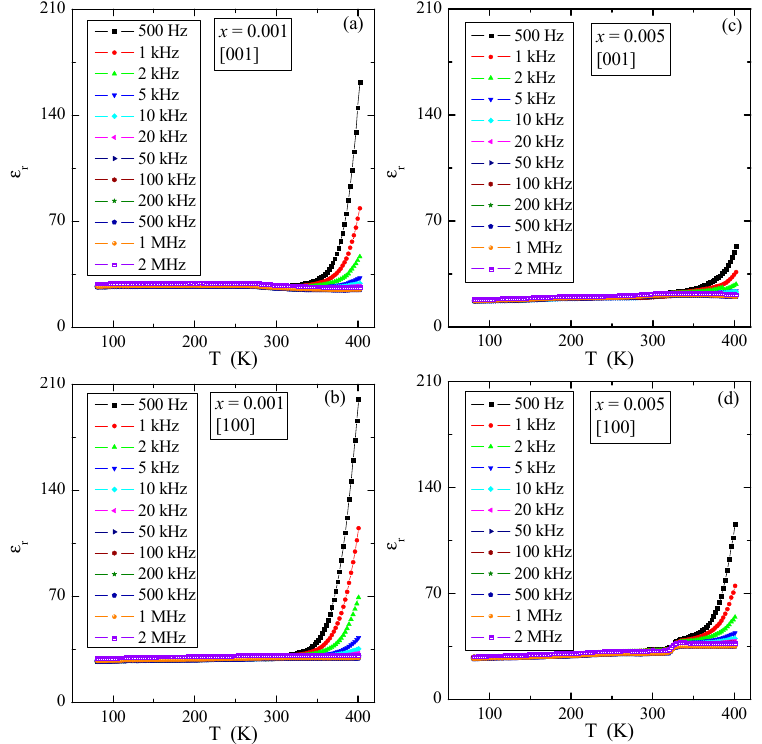
Figure 9. Relative dielectric permittivity ε r vs. temperature T of PNMWO single crystals: ( a ) x = 0.001 and [001], ( b ) x = 0.001 and [100], ( c ) x = 0.005 and [001], ( d ) x = 0.005 and [100].